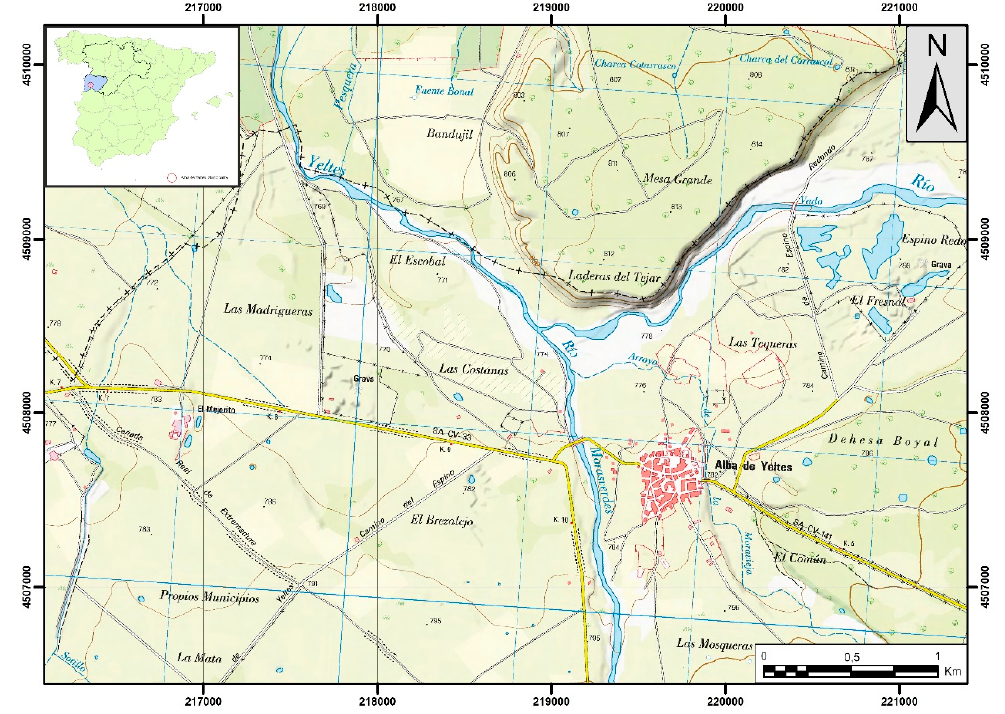
Figure 1. Localization of the study area.